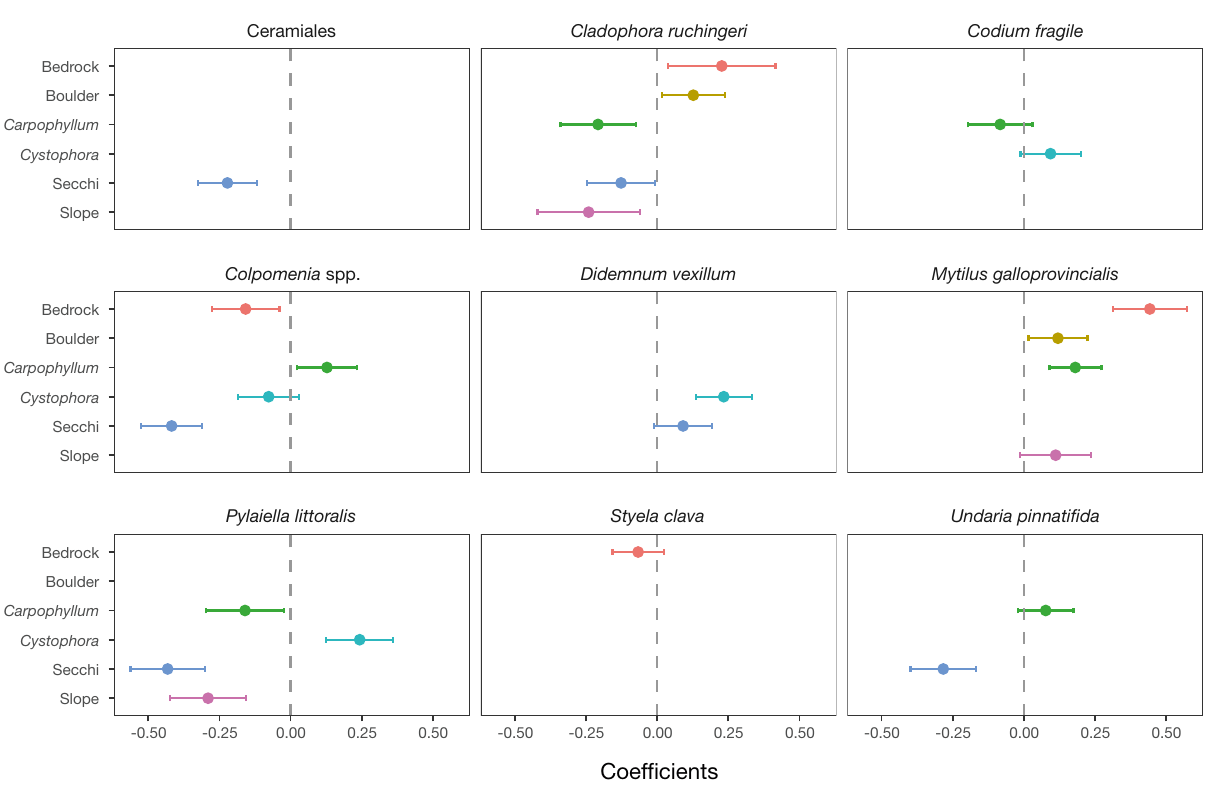
Fig. 6. Coefficients (±95% CI) of beta regression models of the percent cover of each focal taxon in response to substrate type (bedrock and boulder), canopy-forming native algae ( Carpophyllum spp. and Cystophora spp.), Secchi depth, and substrate slope (n = 264). Predictor variables were centred and scaled to allow direct comparison and those not shown were removed during model selection. Statistical significance can be inferred from the overlap of 95% CI with zero (dotted line). Ciona robusta was not included in this analysis as it was not recorded in natural